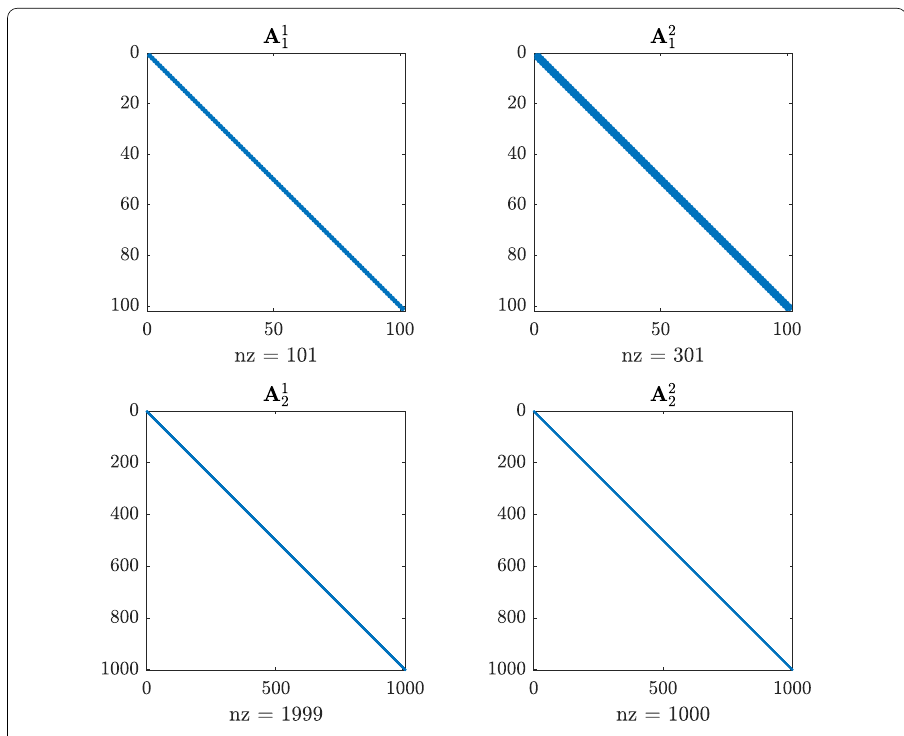
Fig. 3 Sparsity pattern of discrete PGD operators associated with the separated representation (21), for N x = 101 and N t =